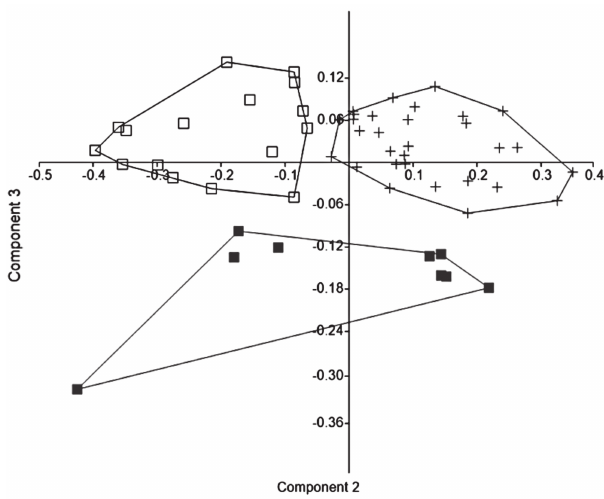
Fig. 10. Scatter plot of combined samples of Rhamdia branneri (n=16, open squares), R. voulezi (n=30, crosses) and R. cf. quelen . (n=9, filled squares) from rio Iguaçu and rio Tibagi (Upper Paraná basin) on the second and third principal component